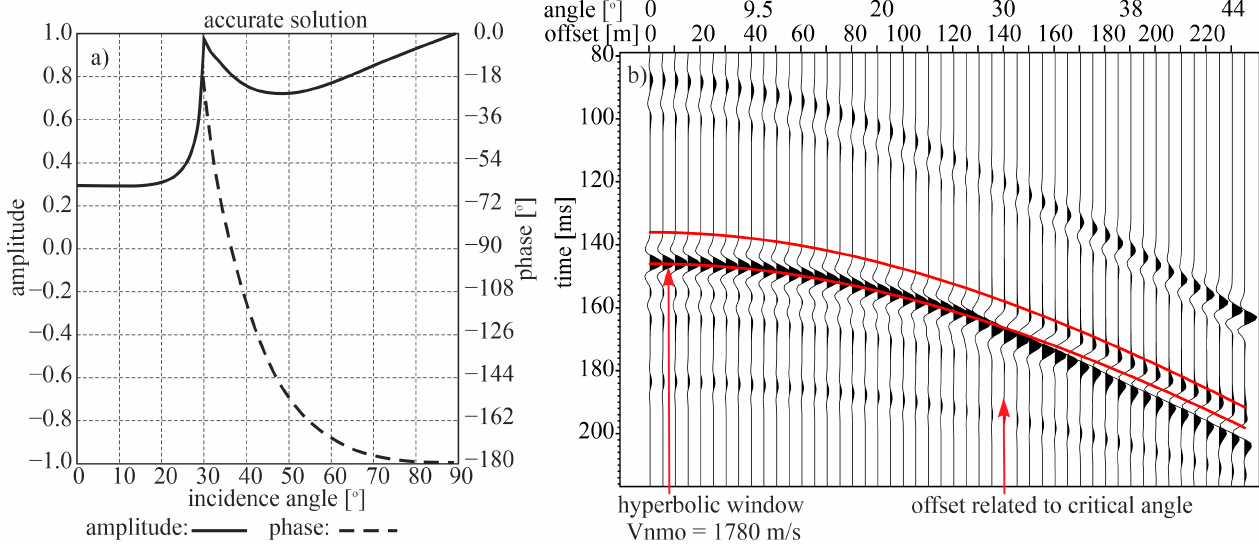
Figure 5. Synthetic seismic response from the carbonate sulphur deposit. ( a ) Change of reflection amplitude and phase of signal as a function of incident angle—accurate solution; ( b ) synthetic CMP gather.